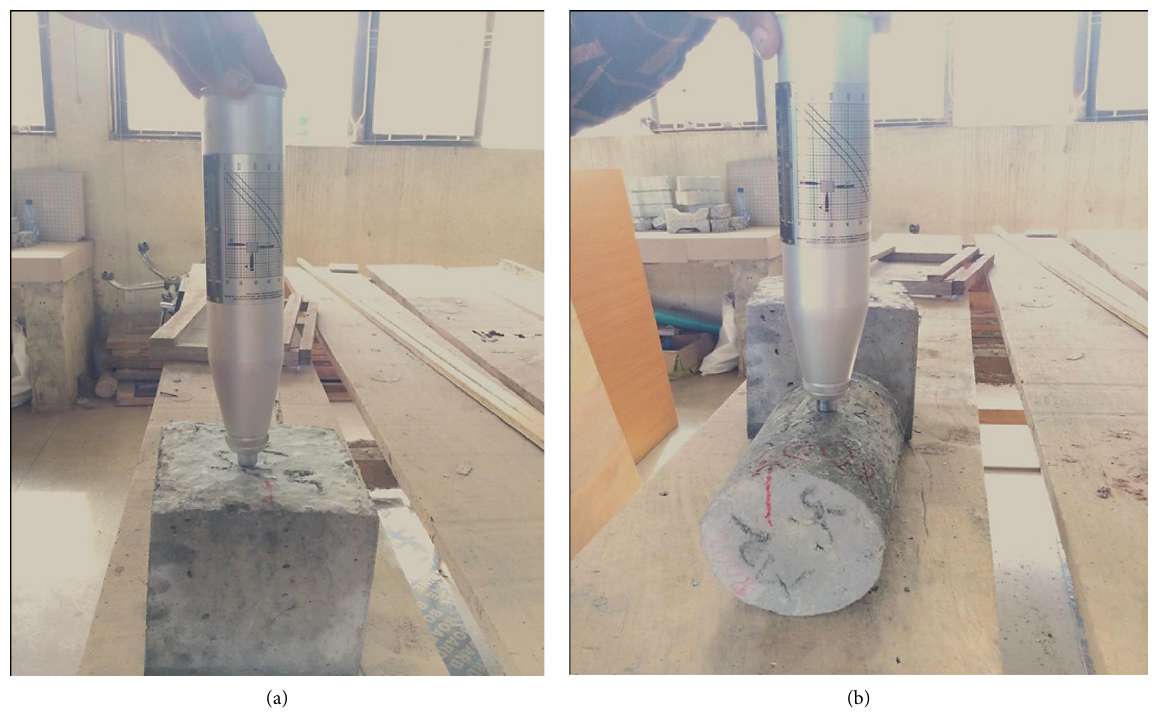
Figure 6: (a) Rebound hammer test on the hardened concrete cube. (b) Rebound hammer test on the hardened concrete